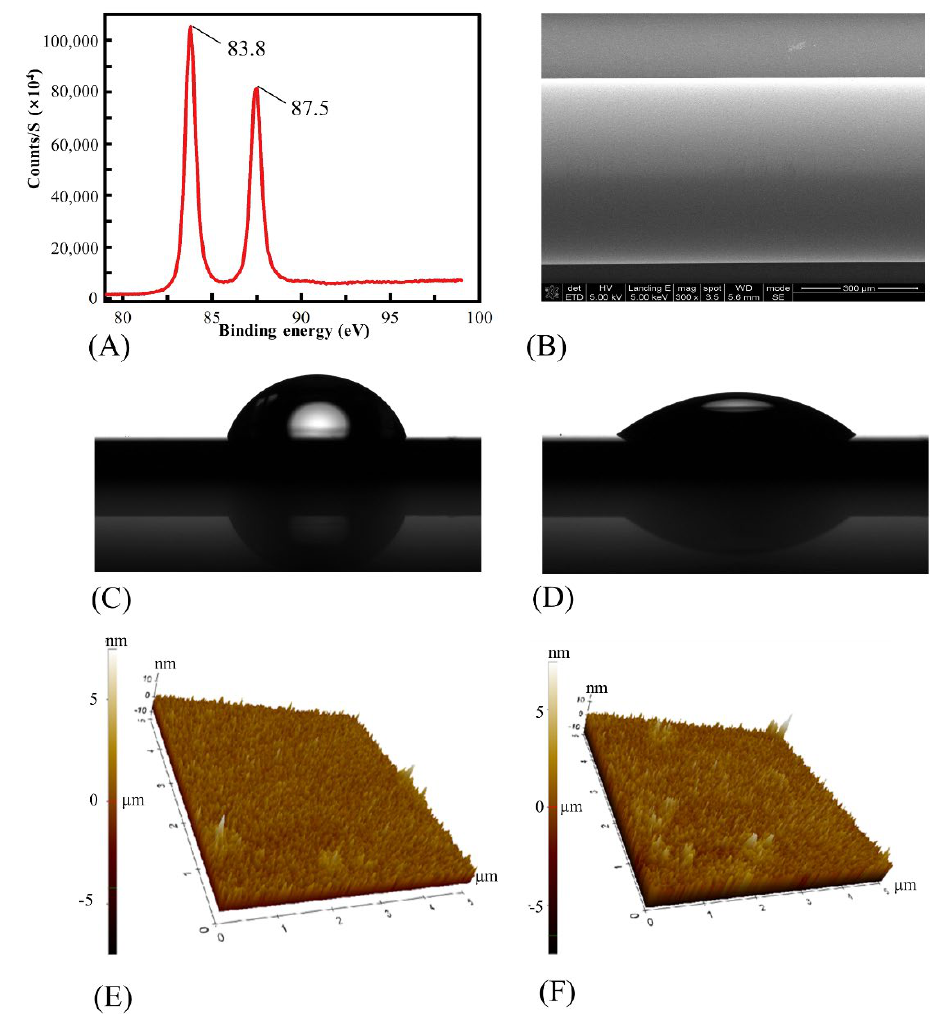
Figure 2. ( A ) The XPS evaluation of the sensing area of the biosensor. ( B ) The SEM evaluation of the sensing area of the biosensor. ( C , D ) The infiltration characteristics of the glass sheet before and after the oxygen plasma treatment. ( E , F ) The surface morphology of the glass sheet with and without oxygen plasma treatment.